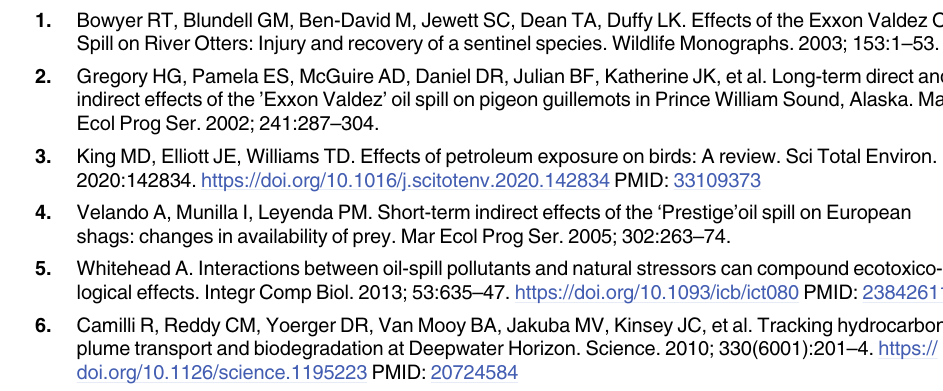
S1 Fig. Vegetation height profiles (mean stem counts ± SE) at Seaside Sparrow nest and paired random points (N = 252 points each) associated with two bays in Louisiana, showing (a) vege- tation structure differences between bays, and (b) evidence of nest site selection by Seaside Sparrows to favor denser vegetation at typical nest heights (20–80